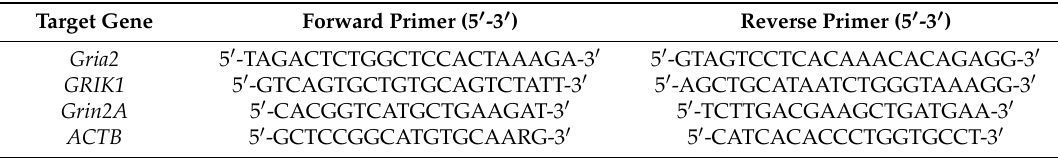
Table 2. Summary of